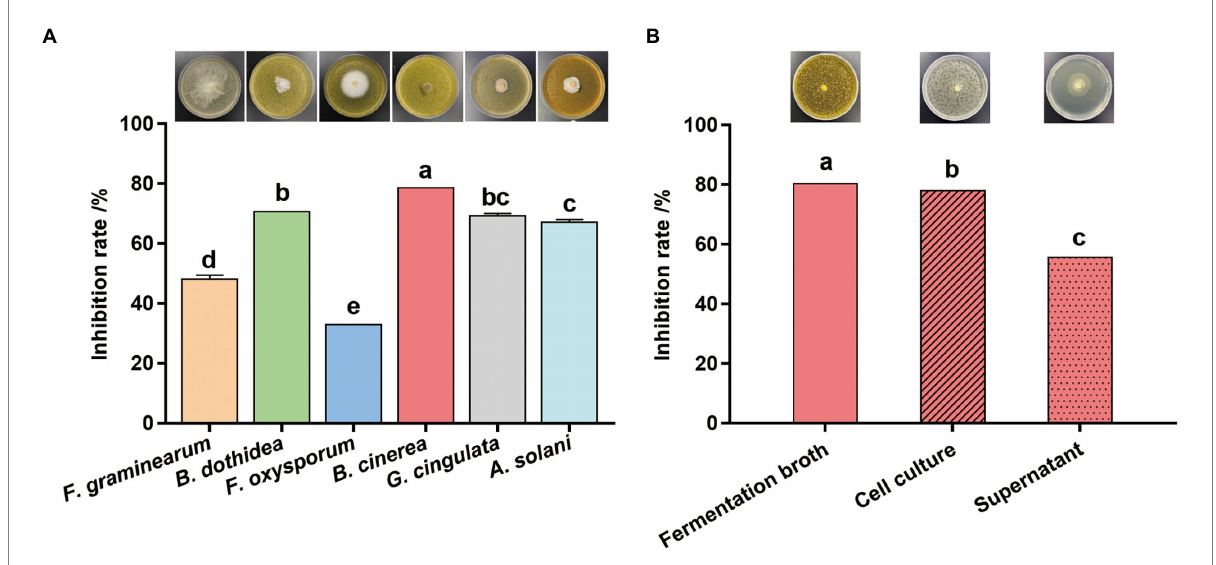
FIGURE 3 Antifungal activity of Streptomyces sp. sdu1201. (A) Antifungal activity of the fermentation broth of Streptomyces sp. sdu1201 against six pathogenic fungi. (B) The inhibitory rate of the cell culture and supernatant of Streptomyces sp. sdu1201 against B. cinerea . Vertical bars represent the standard errors of the means. Different letters above the bars indicate statistically significant differences at p <